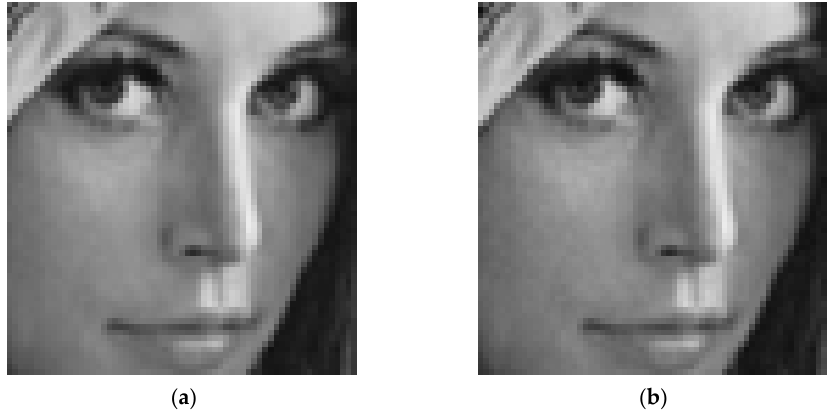
Figure 10. A portion of ( a ) cover and ( b ) stego of the Lena image is zoomed in by 3. No difference is observed between these images. observed between these